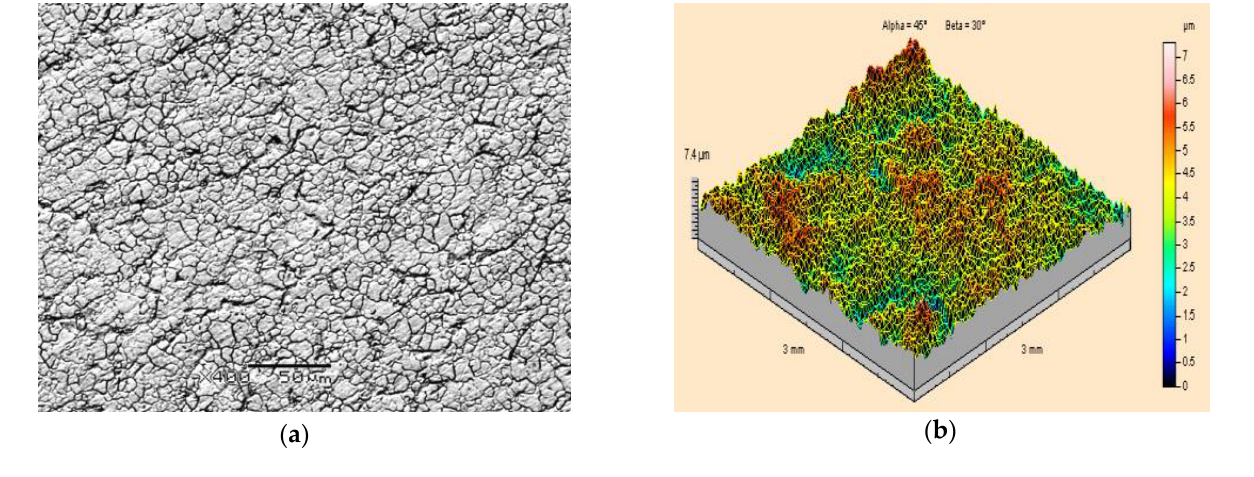
Figure 4. Surface topography of X5CrNi18-10 steel specimens prior to the application of paint coating and prior to ice-water jet treatment: ( a ) Grey scale map under scanning electron microscope (400 × magnification); ( b ) Isometric